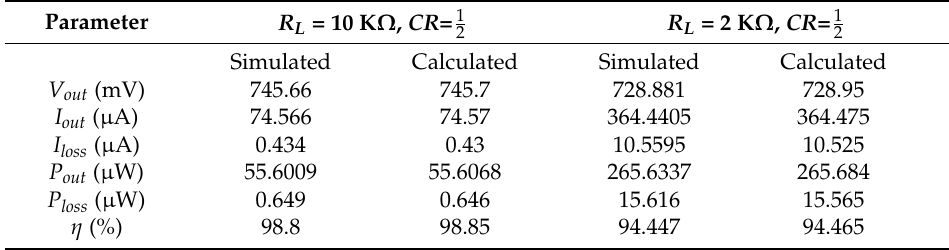
Table 3. Comparison of power efficiency based on simulation and calculation for 1-bit example.